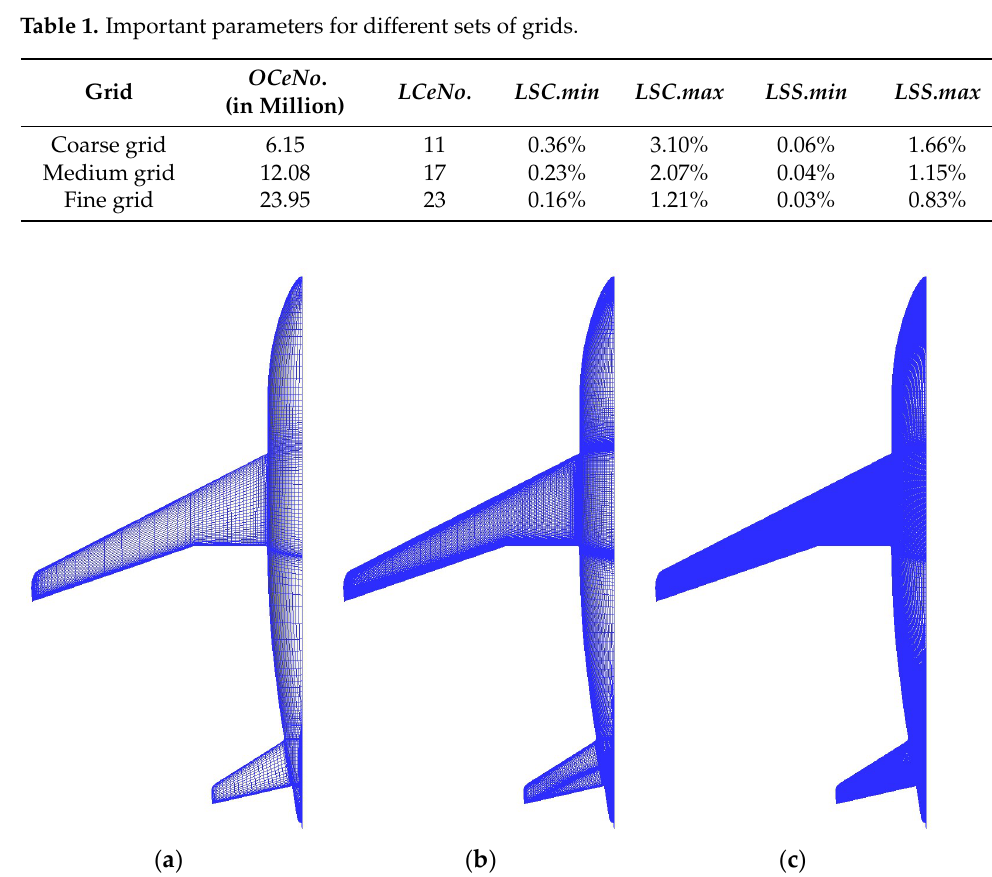
Figure 2. Surface grid distribution. ( a ) Coarse grid; ( b ) medium grid; ( c ) fine grid.